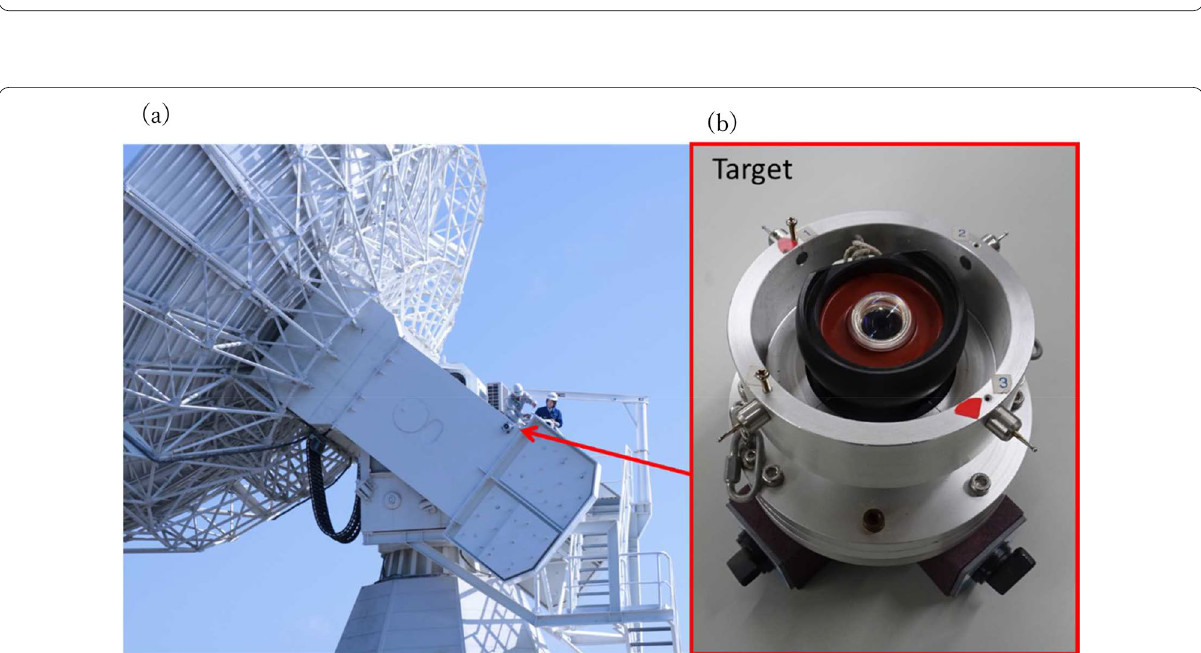
Fig. 4 Target for outside method. a Position attaching target mirror; b target mirror used for outside method